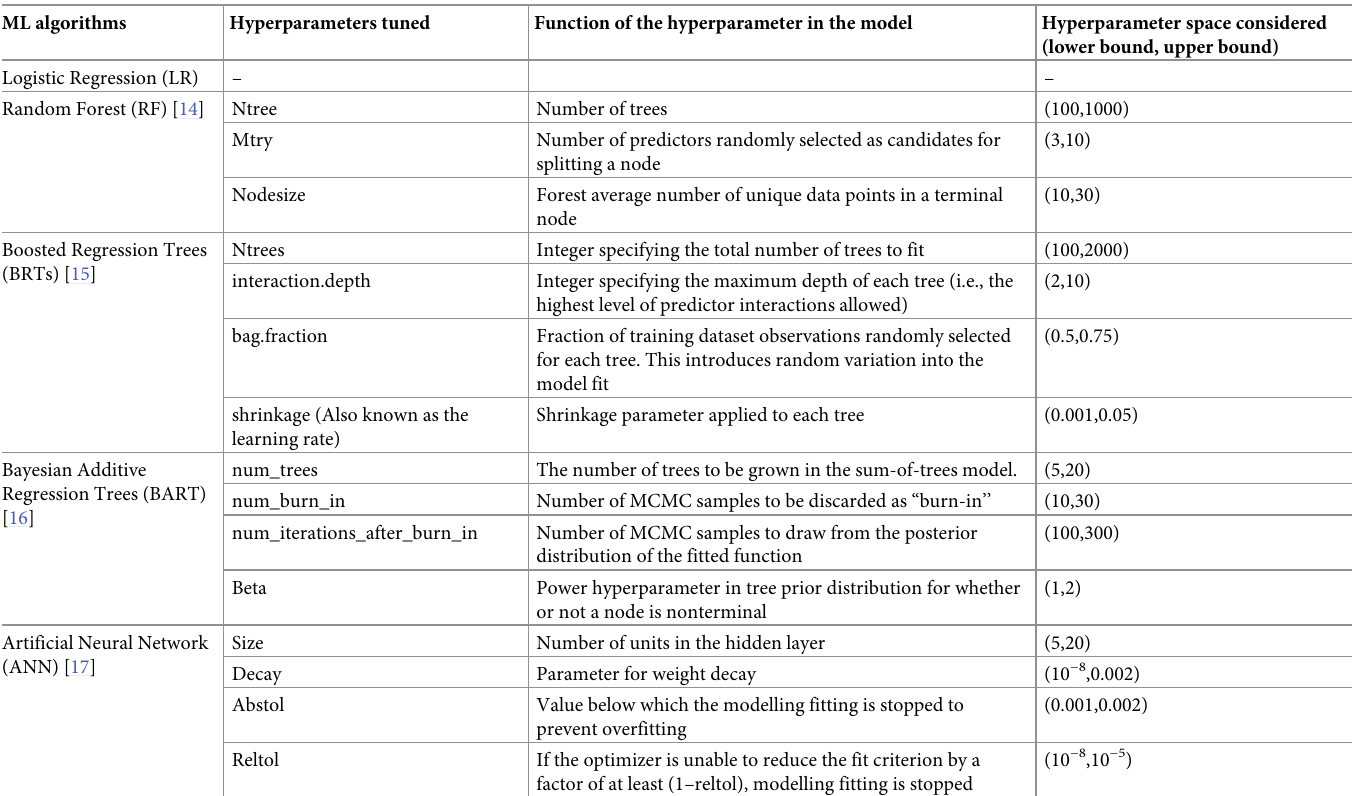
Table 1. Summary of the machine learning algorithms and hyperparameters